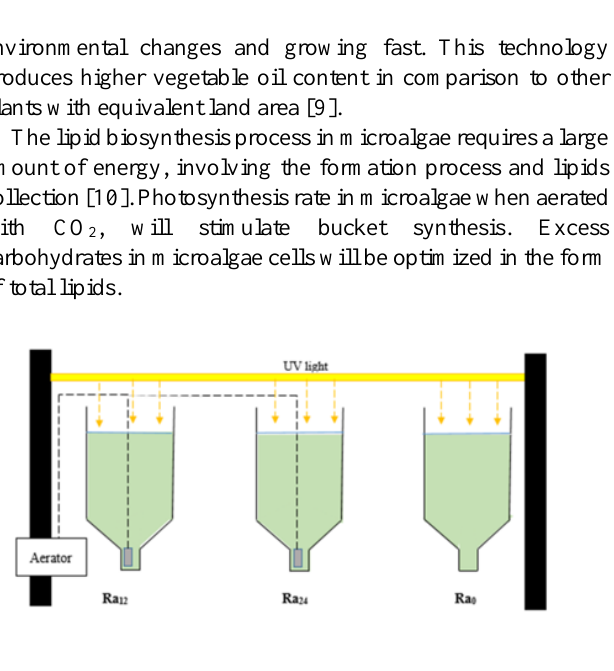
Fig. 1. Illustration of